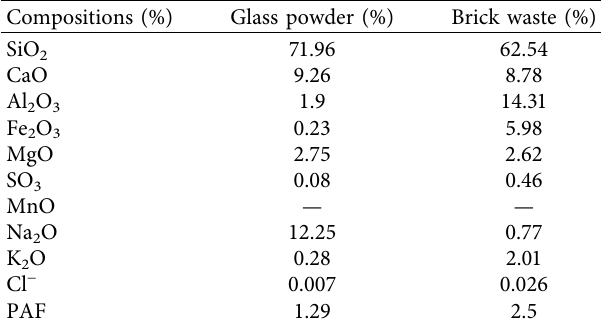
Table 1: Chemical composition of GP and BW. Compositions (%) Glass powder